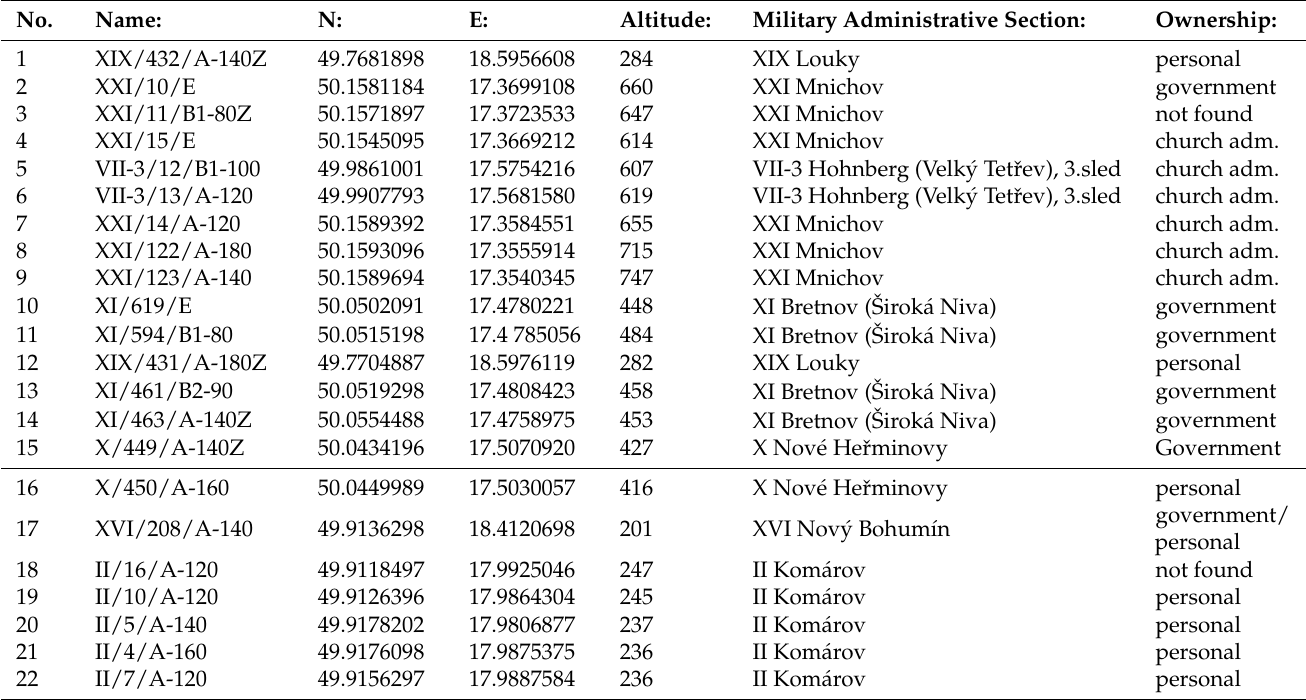
Table A1. Overview table of SA-CEFs studied objects with their description. The numbering of the individual SA-CEFs corresponds to the data in Table 1—part 1.